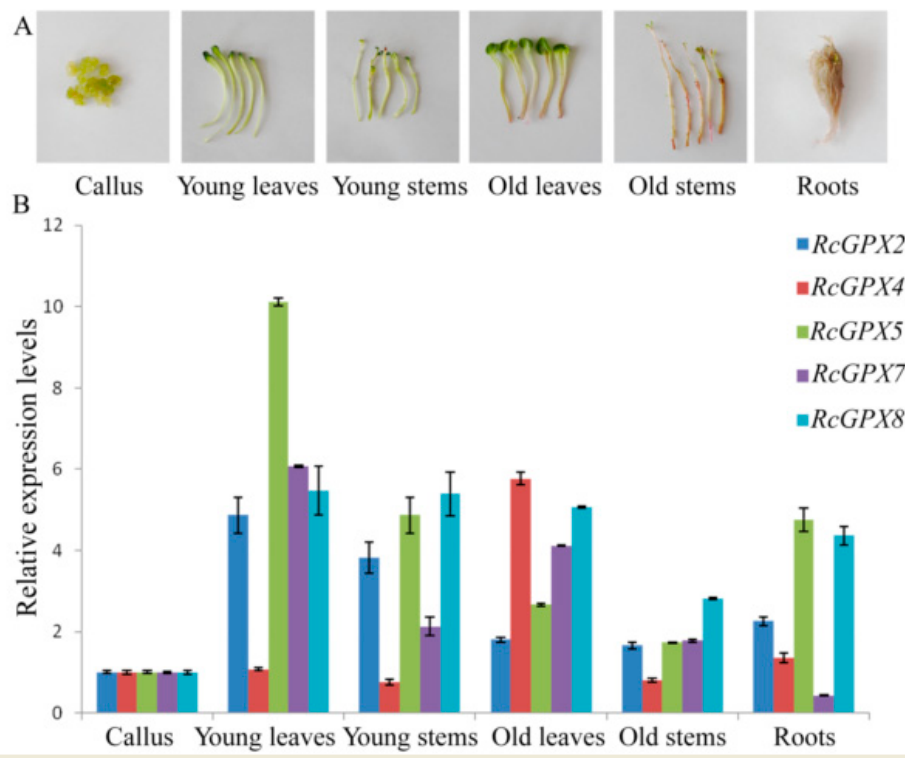
Figure 4. Tissue-specific expression analysis of RcGPXs . Six organs and tissues were used for real-time PCR ( A ). The expression levels of RcGPXs under different development stages or tissues were presented by colors ( B ). mRNA levels were normalized with respect to RcGAPDH and are expressed relative to the values of callus tissue, which were given an arbitrary value of 1. Data represent the means ± SE of at least three replicates.